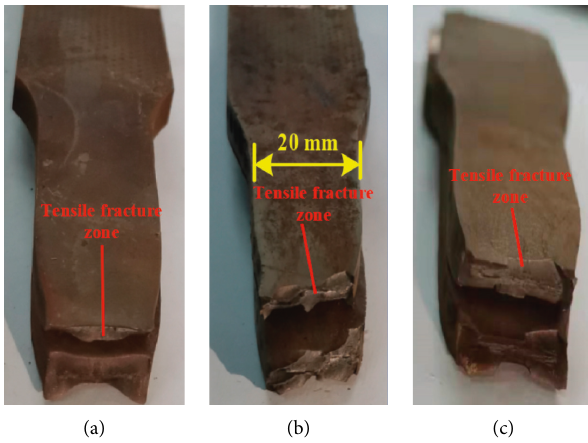
Figure 10: Fracture morphology. (a) Arc fracture. (b) Oblique fracture. (c) Ladder fracture.